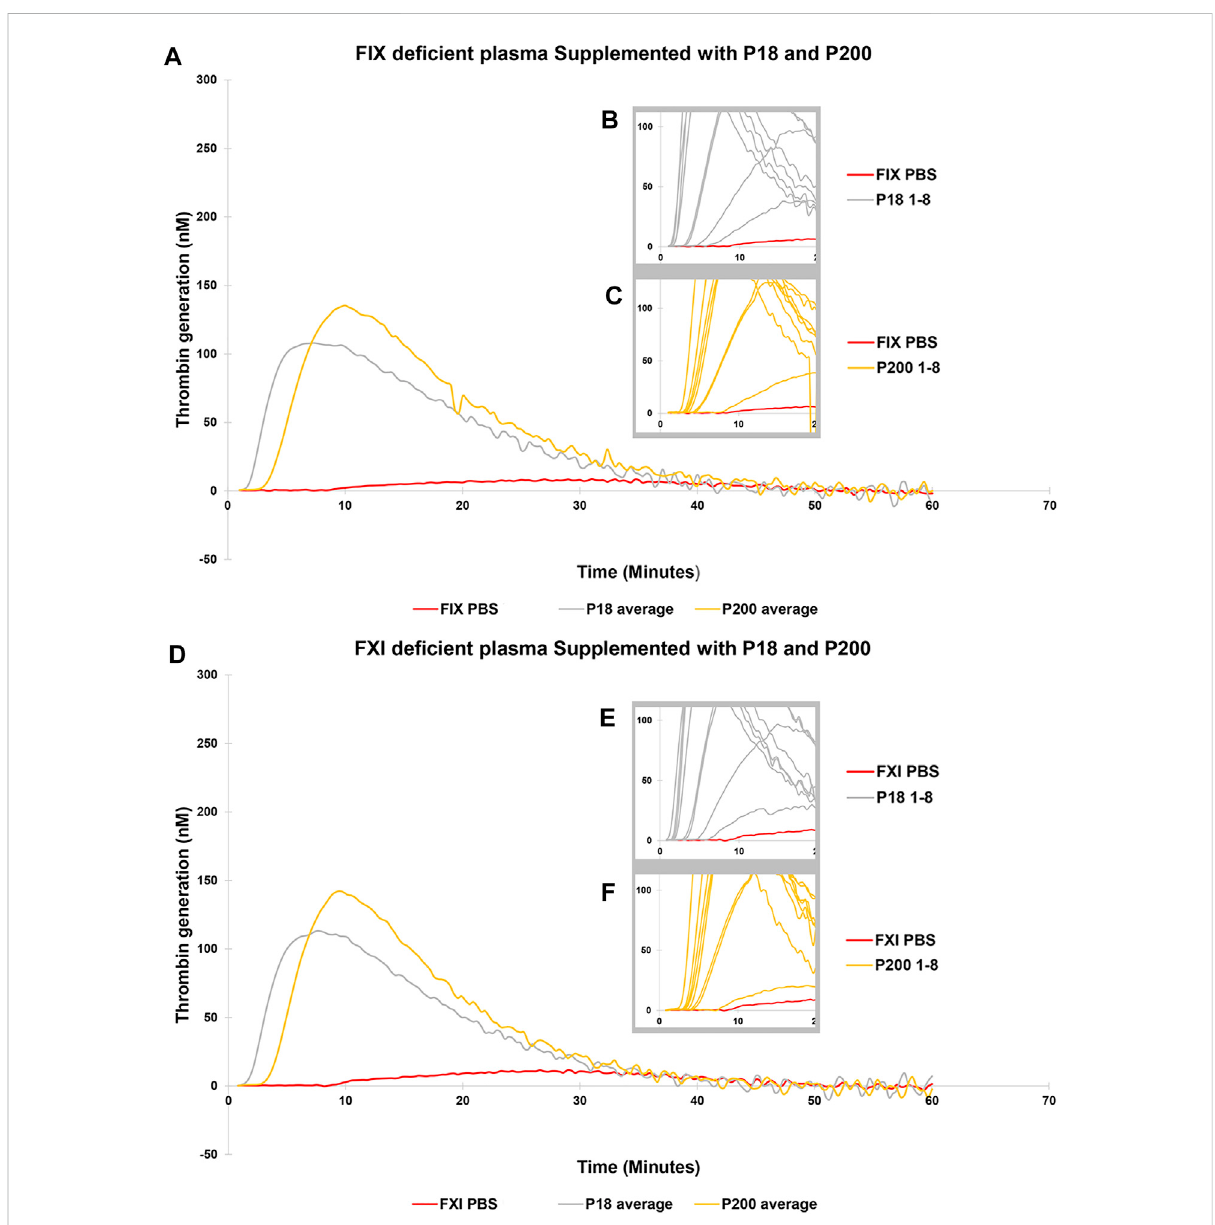
FIGURE 4 Thrombin Generation measured by Calibrated Automated Thrombogram (CAT ® ) is rescued in FIX and FXI de fi cient plasmas by adding urinary extracellular vesicles. EVs (P18 (Grey line, microvesicles) and P200 (Orange line, exosomes) were supplemented into FIXde fi cient plasma (A – C) , and TG was measured after challenging the plasma with the PRP reagent (1pM TF without PLs). Similarly, P18 and P200 were supplemented into FXI de fi cient plasma (D – F) , and TG was measured after challenging the plasma with PRP reagent. Diluted plasma (with PBS at same volume as EVs) was used a control (Red line). In A and B the averages at every time point for 8 samples for both P18 and P200 are shown. The average is depicted to enhance clarity. Inset diagrams (B and C for FVII and E and F for FVIII) show a cut portion of the original diagram with 8 individuals ’ measurements to highlight the differences in lag time (start of the TG) between individuals (not evident in A and D). X-axis represents time and Y-axis TG in nM. Individual curves and statistics are described in Supplementary Figures S12,